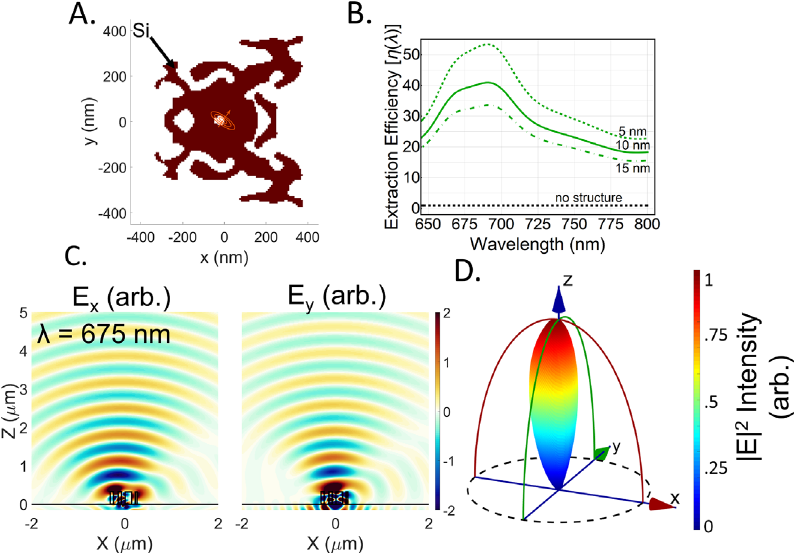
far fi eld. NLE, nanoscale light extractor; NV,